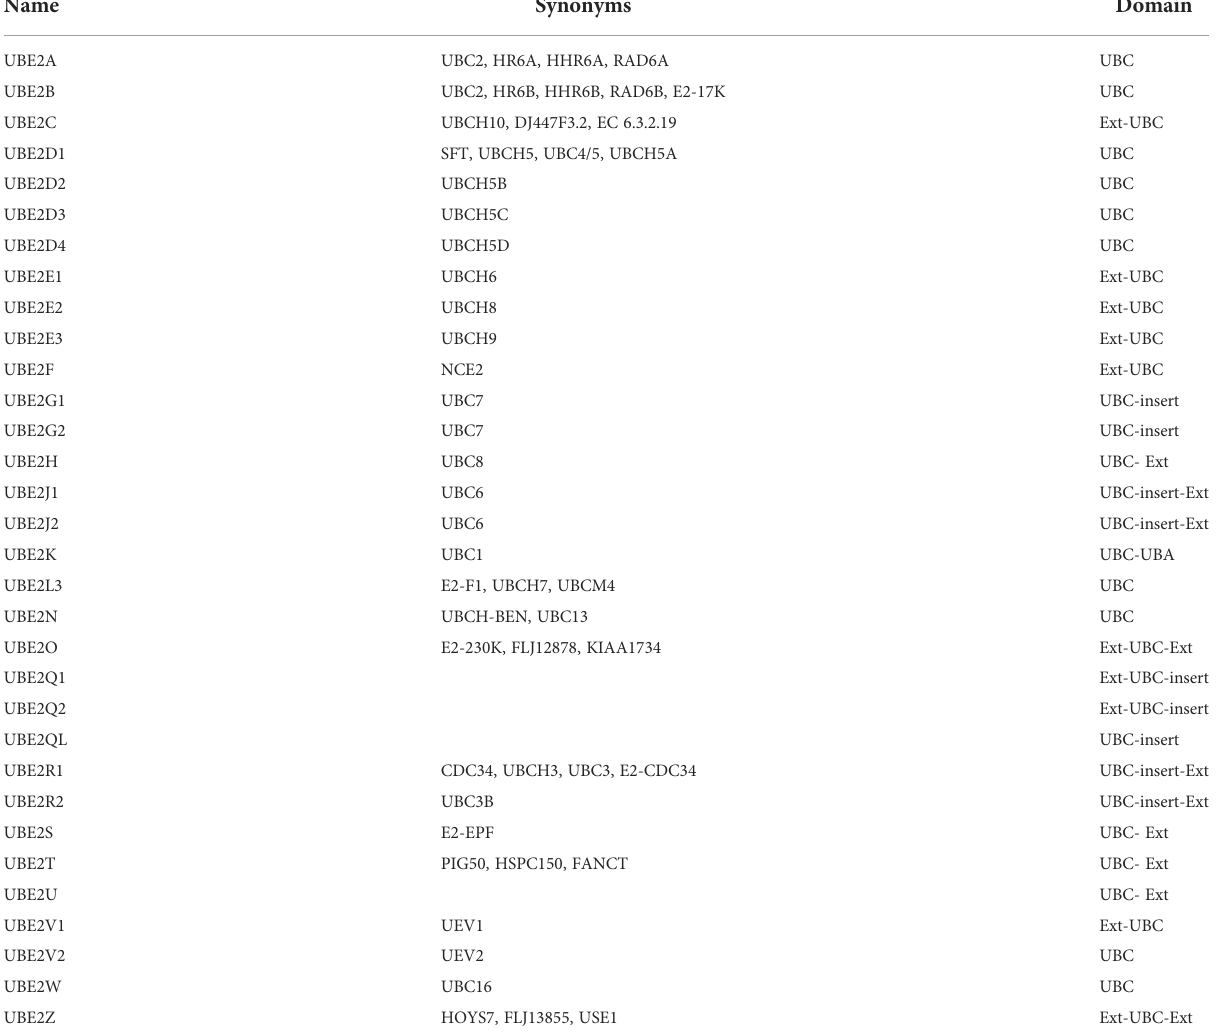
TABLE 2 E2 enzymes and their speci fi c domain. Name Synonyms